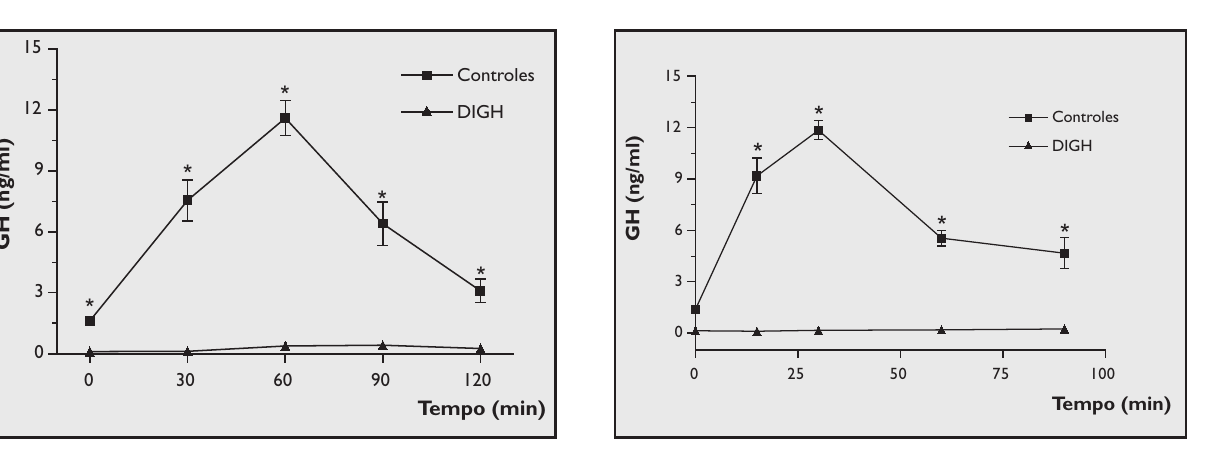
Figura 2 – Concentrações séricas de GH em indivíduos portadores de DIGH e controles após teste de hipoglicemia insulínica em Itabaianinha, Sergipe, 2003.